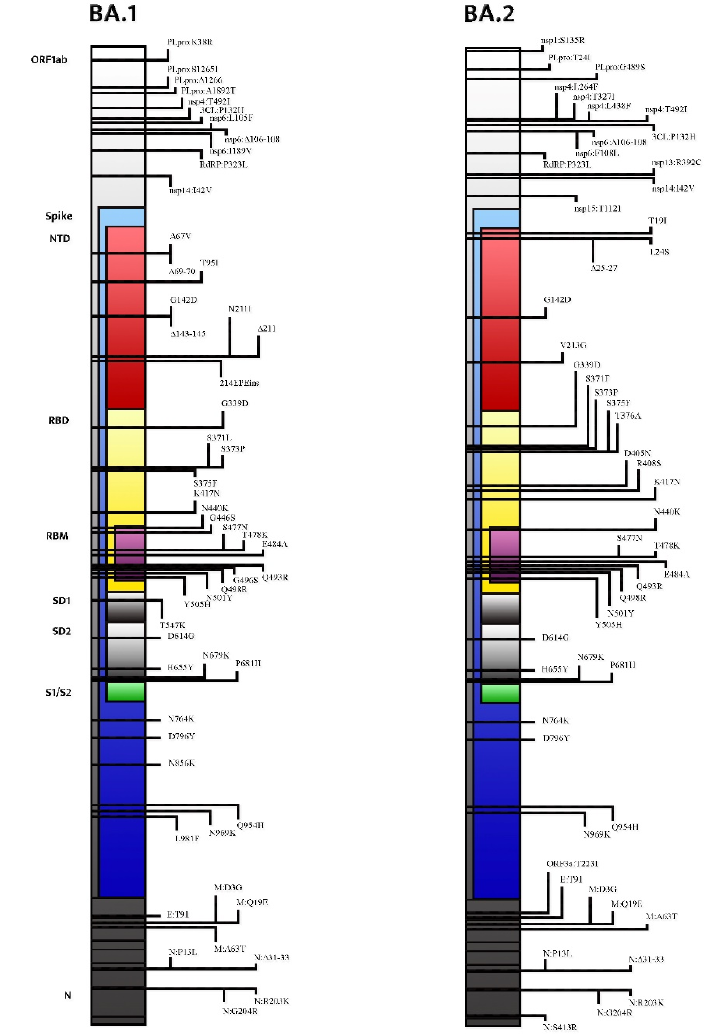
Figure 1. Mutational profile and main differences between the Omicron BA.1 lineage and the Omicron BA.2